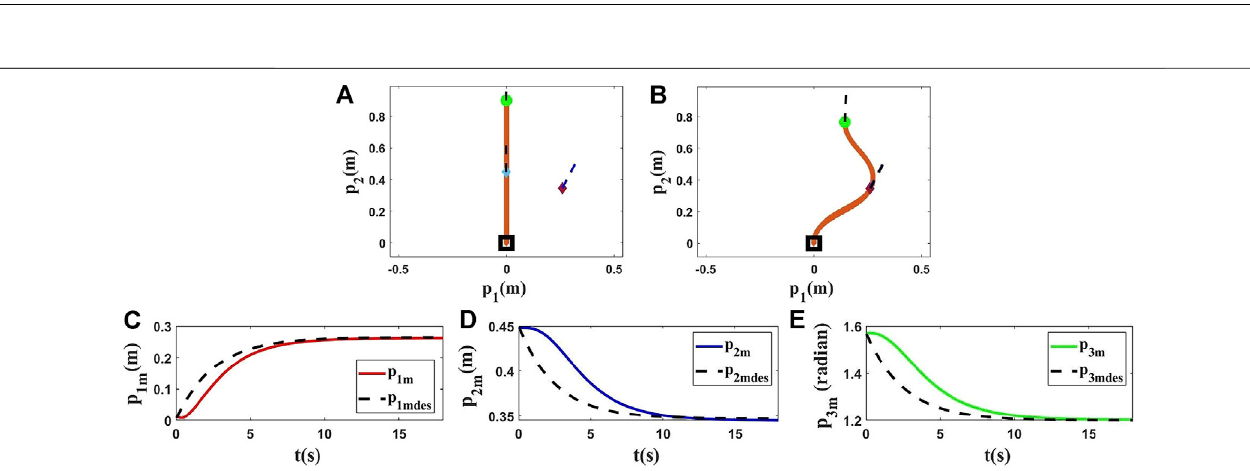
FIGURE 3 | Simulation 1. First row: (A) and (B) are the initial and fi nal shape of the object, respectively. The desired state of the point m is shown as a purple diamond (position) and a dashed line segment (orientation). L is 0.70( m ), M at time zero is M 0 = [0.0000, 0.2310, 1.5708] T , and M fdes = [0.1200, 0.1820, 0.7600] T . After applying the proposed controller, the fi nal state of M is M f = [0.1206, 0.1820, 0.7610] T . Second row: (C) , (D) and (E) show the states of the controlled point regarding their desired trajectories. Third row: (F) , (G) and (H) show ^ a 10 , ^ a 20 and ^ a 30 in the fi rst simulation using the Kirchhoff model.